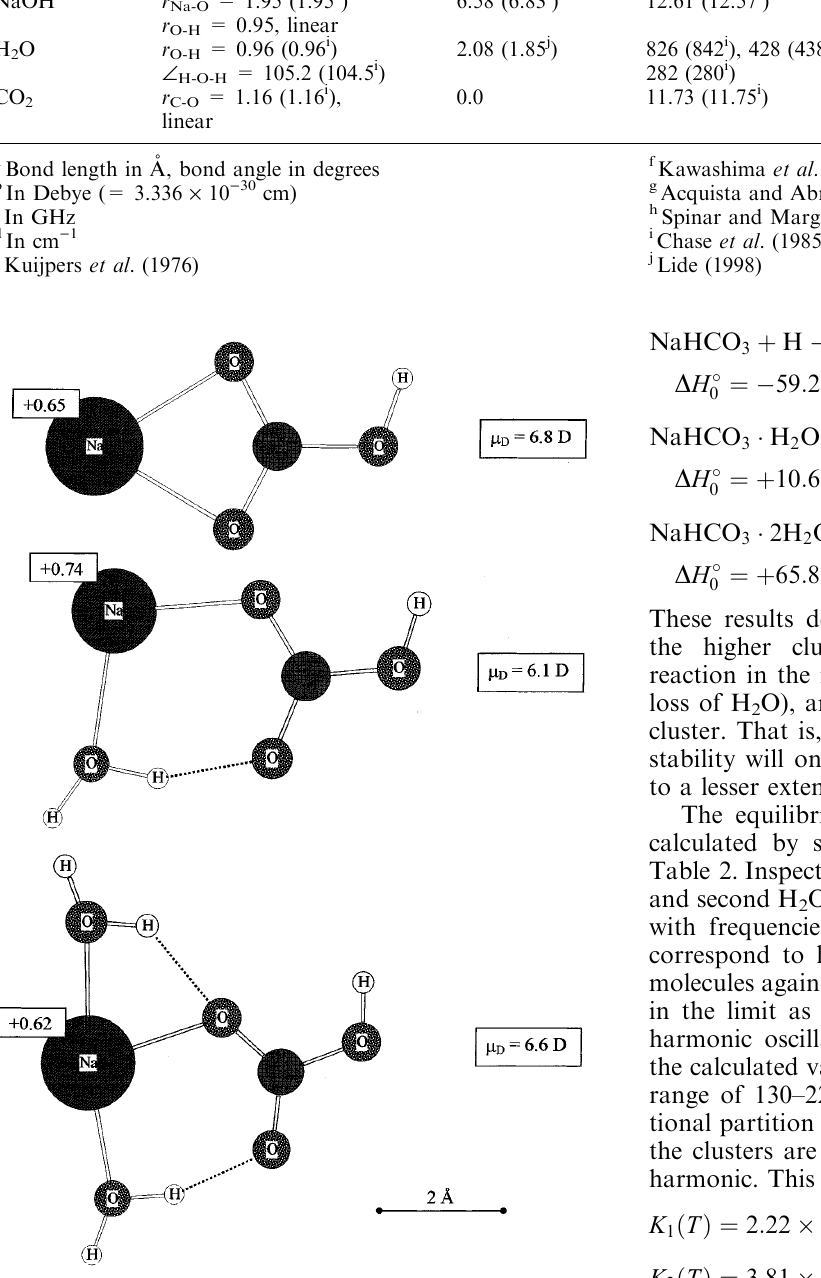
Fig. 3. Geometries and dipole moments ( l ) of NaHCO and the D 3 first and second H O clusters, calculated at the B3LYP/6- 2 311+G(2d,p) level of theory. All structures are planar. The dark shaded atomic centre is carbon